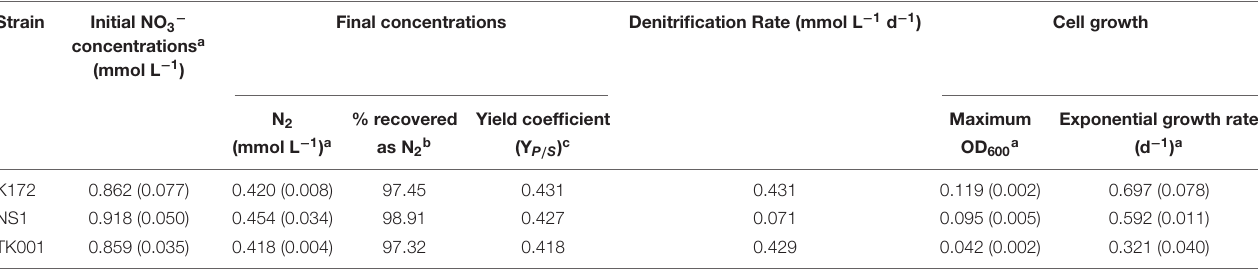
a Numbers in parentheses are standard errors for three to four replicates. b % N 2 recovered = (Total N 2 produced in culture bottles/(0.5*Initial